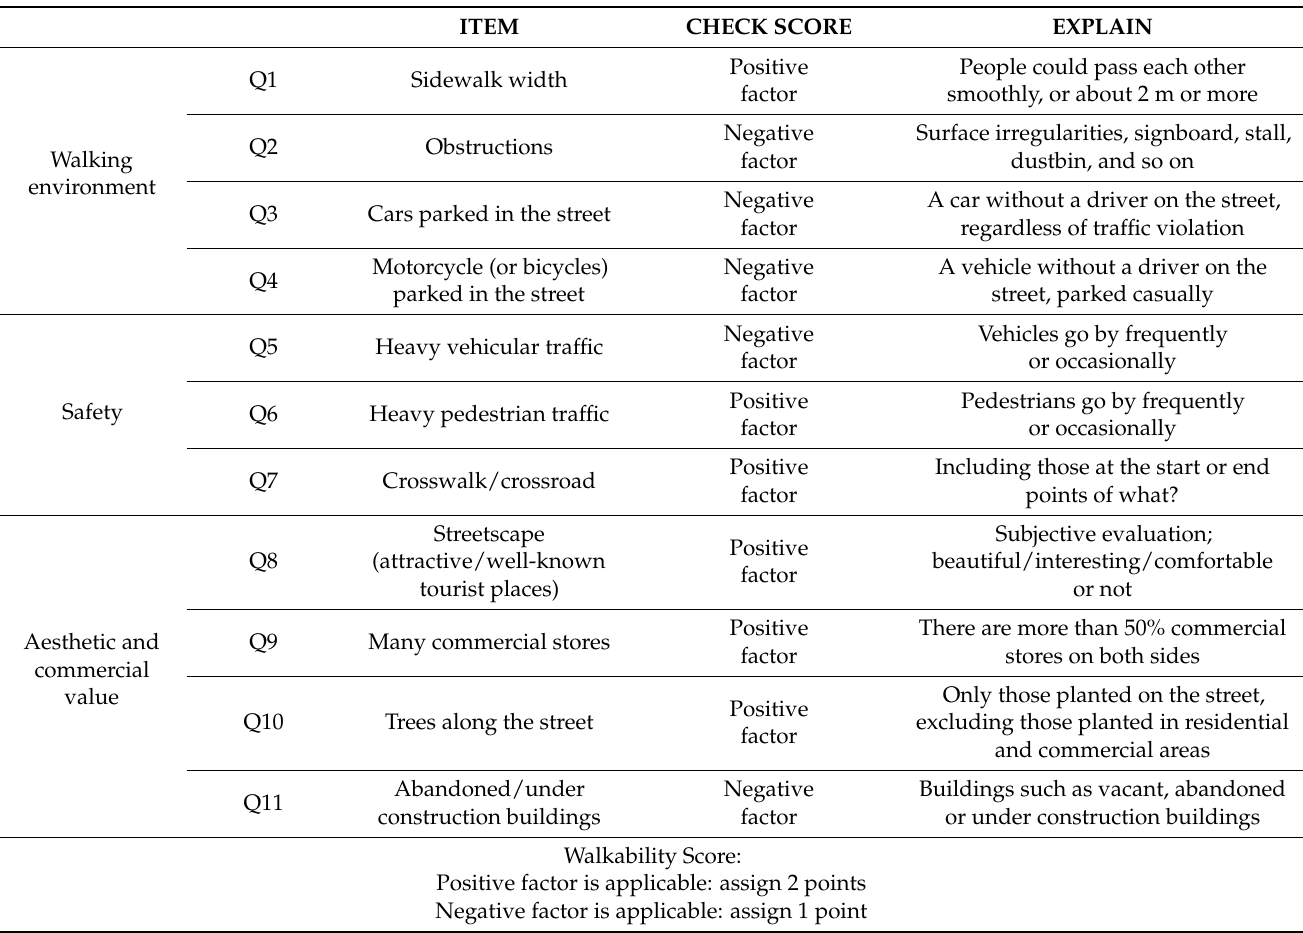
Table 1. Walkability